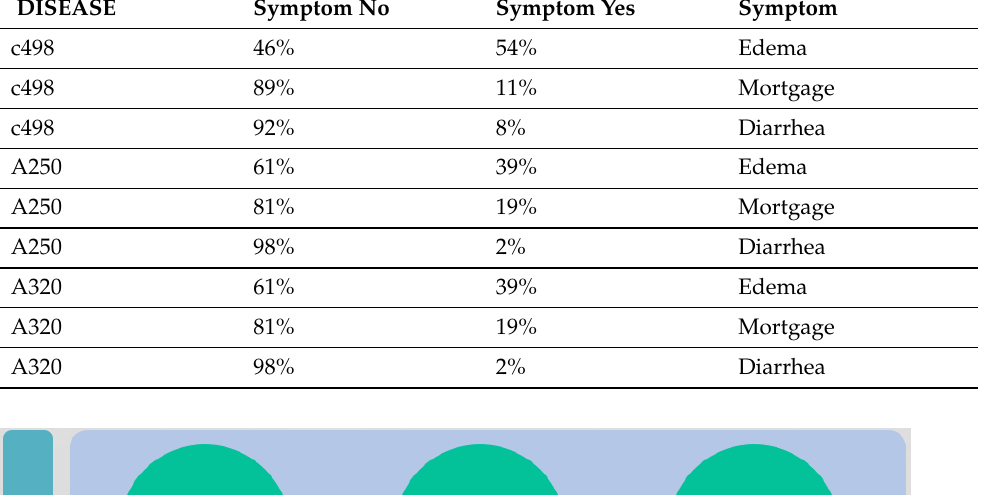
Table 2. DAG probabilities for disease–symptom.